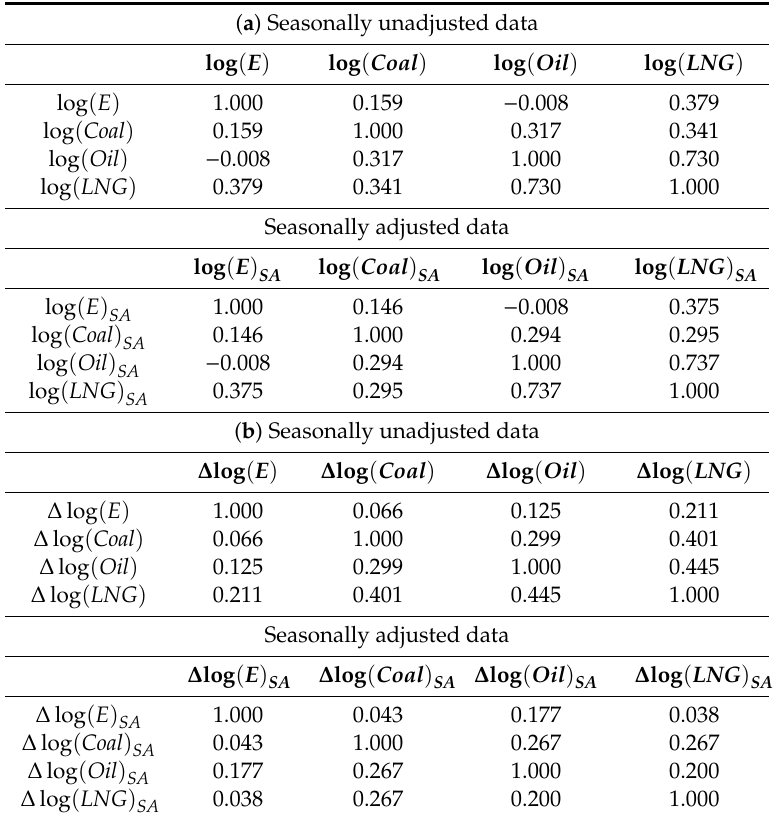
Table 3. ( a ) Correlation: Levels. ( b ) Correlation: First di ff erences.